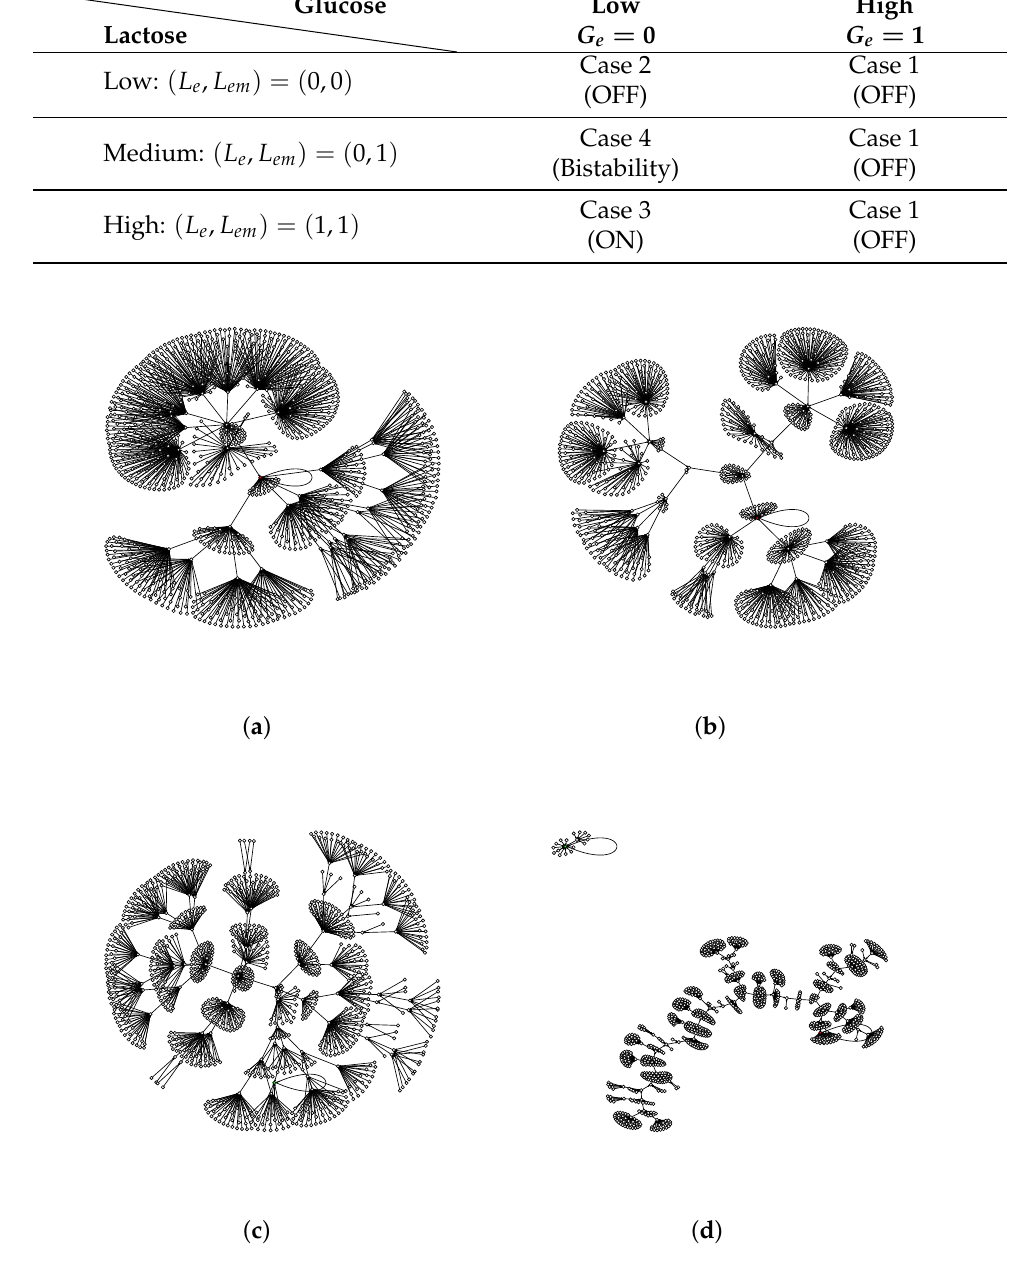
Figure 4. State transition graphs of the original model under parallel update schedule for: ( a ) Case 1, ( b ) Case 2, ( c ) Case 3 and ( d ) Case 4 (bistability appears). The circles represent all the 2 10 = 1024 configurations ( M , P , B , C , R , R m , A , A m , L , L m ) ∈ { 0,1 } 10 , in particular, the red one correspond to the steady state OFF while the green one correspond to the steady state ON. The sizes of its attraction basins are 1024 for cases 1, 2 and 3 and 1006 and 18 for the OFF and ON steady states of case 4,